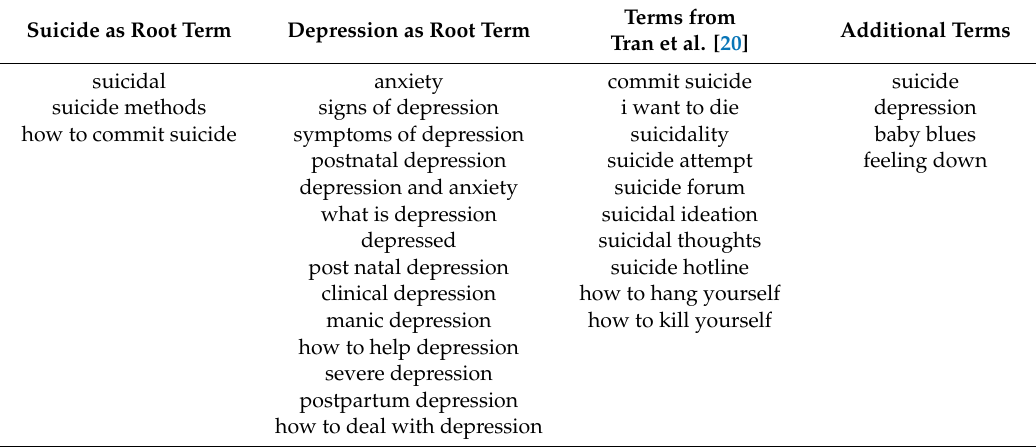
Table 1. Search queries gathered. The first two columns indicate search queries related to “suicide” and “depression”, suggested from Google Trends. The third column represents the terms cited in Tran et al. Additional terms are present in the last